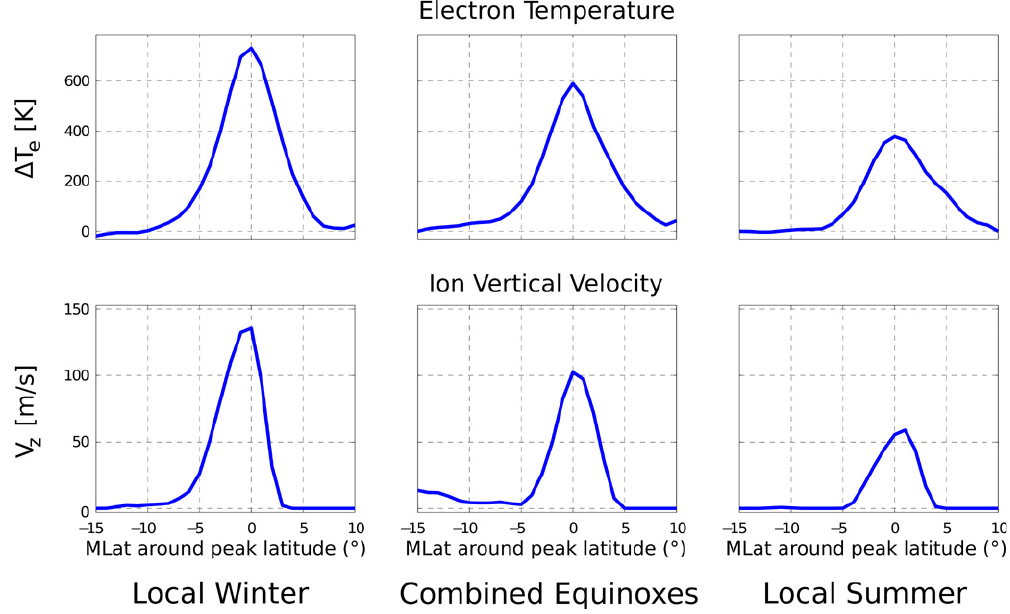
Fig. 7. Electron temperature rise 1T e (top row) and ion vertical velocity V z (bottom row) with the background removed for the three local seasons. Data are the same as in Fig.